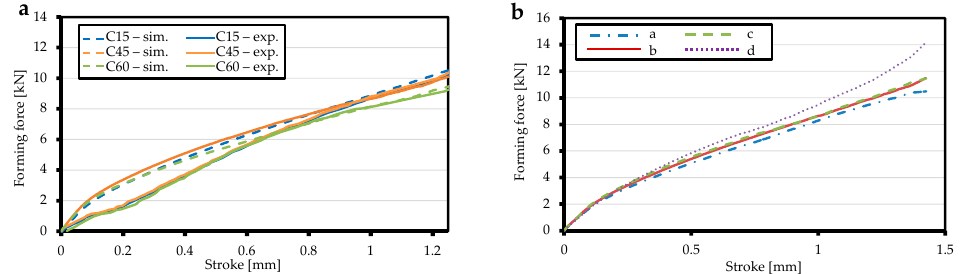
Figure 8. Comparison of experimentally-measured and numerically-predicted force-displacement curves for the steel grades C15, C45, C60 at a temperature of 1000 °C, an average forming speed of 3.2 mm s − 1 , and the calculated ratio of 64:30:6 for the layers wuestite, magnetite, and haematite ( a ); Comparison of numerically-calculated force-displacement curves for the steel C15 at a temperature of 1000 ◦ C, an average forming speed of 3.2 mm s − 1 , and various ratios of haematite, magnetite, and wuestite a: 1:4:95; b: 6:30:64; c: 5:40:55 and d: without oxide scale. ( b